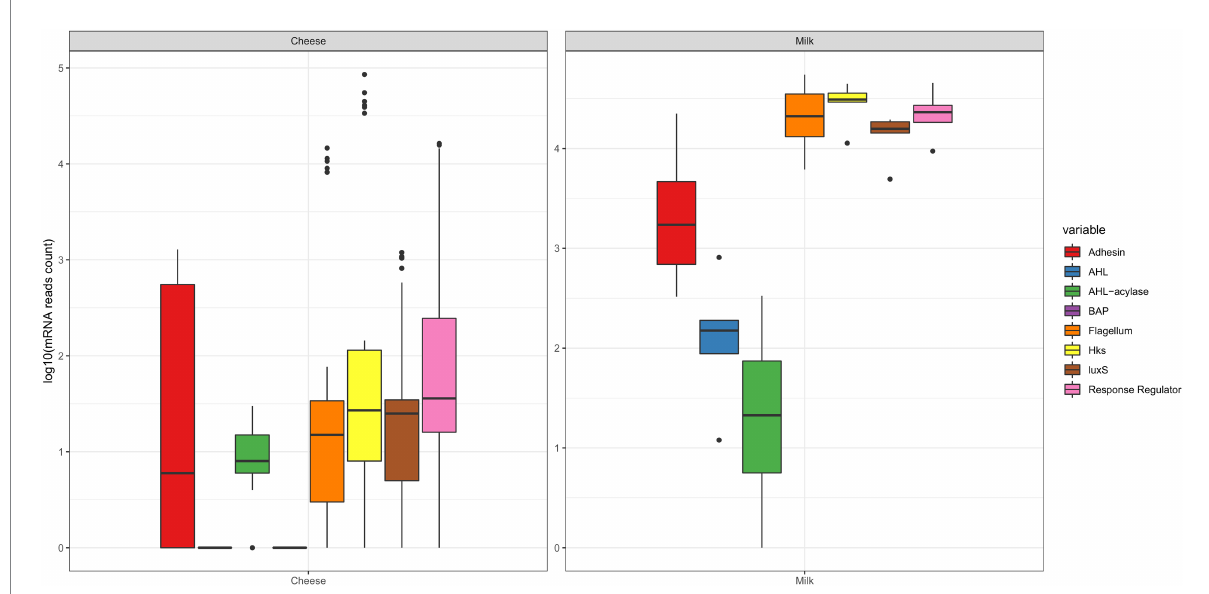
FIGURE 1 Boxplots showing the abundance variation of biofilm-related effectors expressed by the microbiota from cheese and milk samples (log 10 read counts of mRNA), according to search done in publicly available metatranscriptomic databases, which included: adhesin, BAP, flagellum-related, intraspecific QS (AHL, HK, and RR), interspecific QS (LuxS) and QQ (AHL-acylases). The horizontal lines inside the boxes indicate the median values, and the dots outside the boxes represent outliers. Lines were plotted for the AHL and BAP in the cheese group because singletons were detected. BAP reads were not detected for milk samples. The RR category comprises a great diversity of effectors, and they presented large expressions (as detailed next in Figure